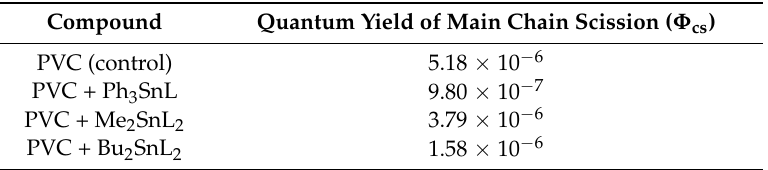
(0.5 wt %) after irradiation (300 h).